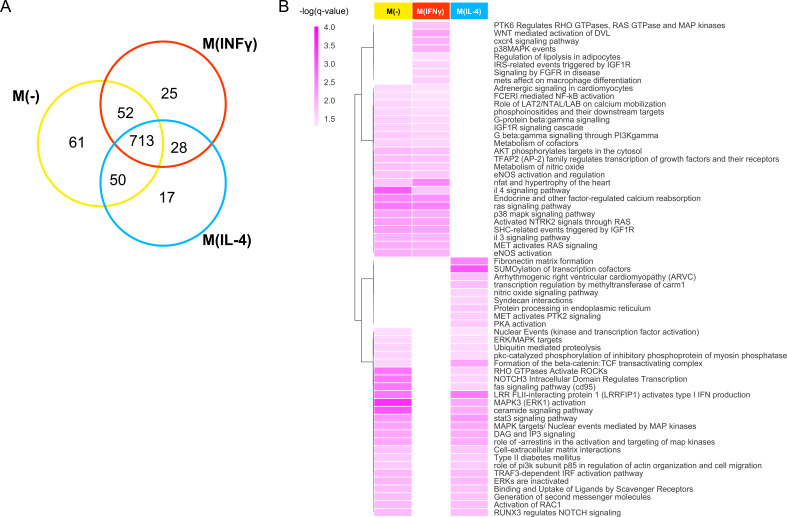
Pathways of top prioritized proteins.(A) The Venn diagram showing the shared pathways between the significantly enriched (q-value <0.05) pathways of the top candidates (empirical p-value<0.01) prioritized by the addition of the M(-), M(IFNγ) and M(IL-4) co-abundance networks to the PPI network. (B) The hierarchically clustered condition-specific pathways (see Figure 3—figure supplement 1 for a full list). Darker shades of colors indicate a higher enrichment in terms of the negative logarithm of q-value.Figure 3—source data 1.Source data for Figure 3: All enriched pathways of the top N (p<0.01) prioritized proteins.